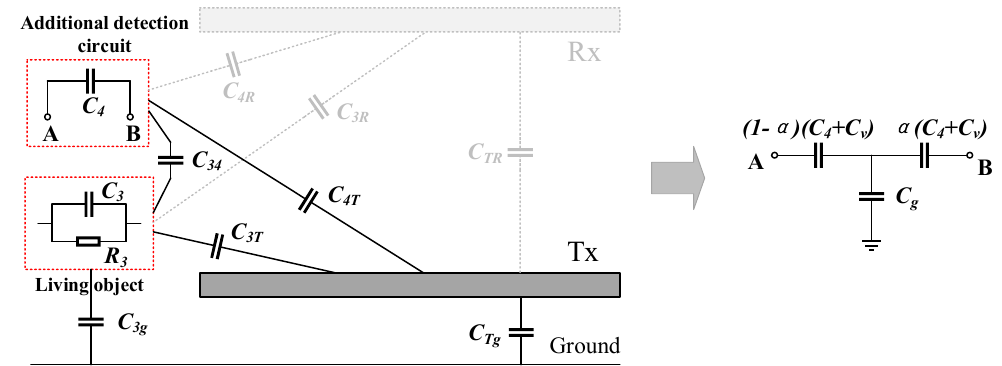
Figure 13. Equivalent circuit of the sensing pattern considering the effect of a living object. C represents the capacitance variation of the sensing pattern in the presence of a living object. v